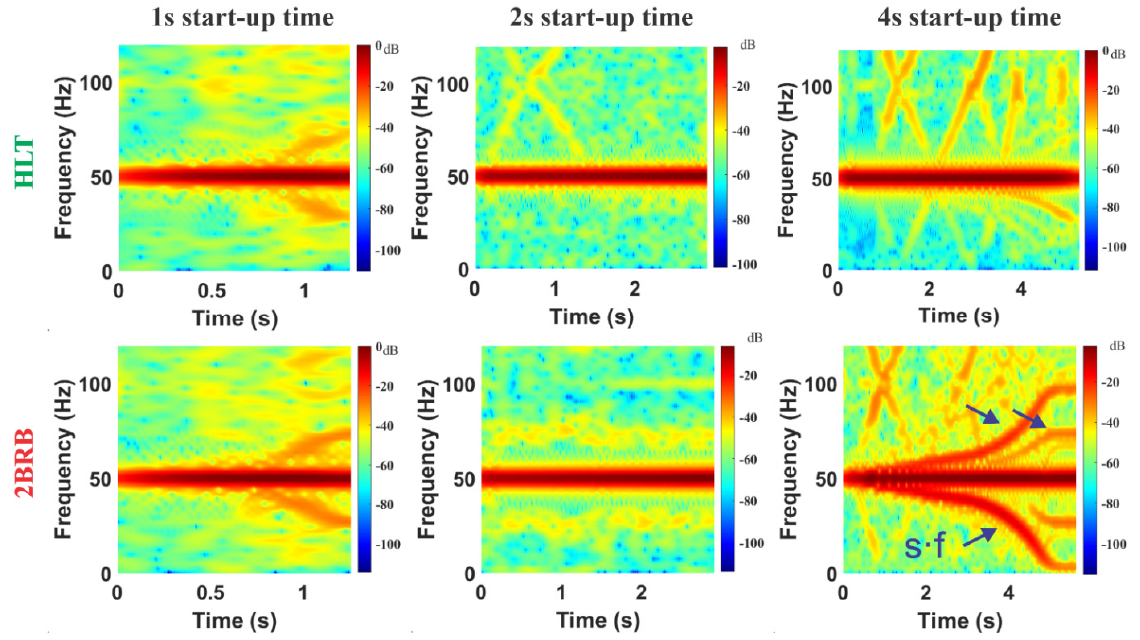
Figure 10. STFT t-f maps obtained by analyzing the stray flux signal of the IM for different start-up time transients when using Schneider soft-starter for a healthy motor, and two broken rotor bars.